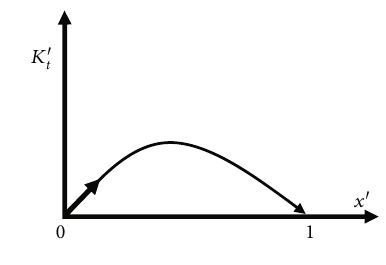
Figure 5: Bank selects the credit